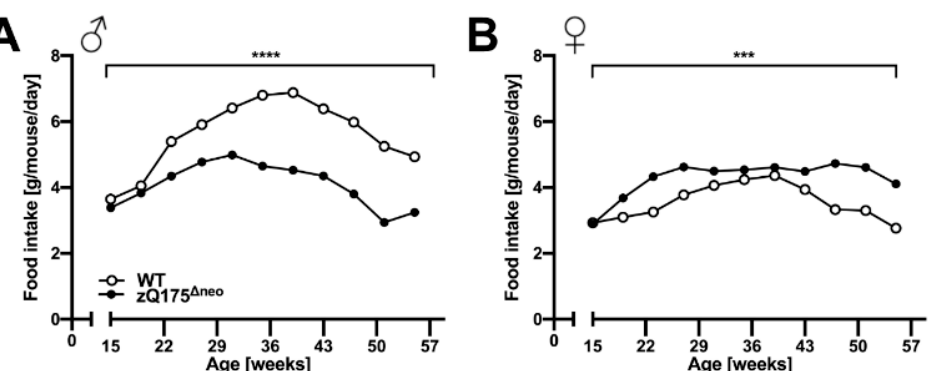
Figure 3. Male ( A ) and female ( B ) zQ175 ∆ neo mice ( • ) consumed significantly less food compared to WT littermates ( ○ ) in the period between 15 and 57 weeks of age. Data are presented as daily consumption per mouse, established from six animals/cage/week. Significance was calculated using paired t -tests and is given as ***: p ≤ 0.001, and ****: p ≤ 0.0001.